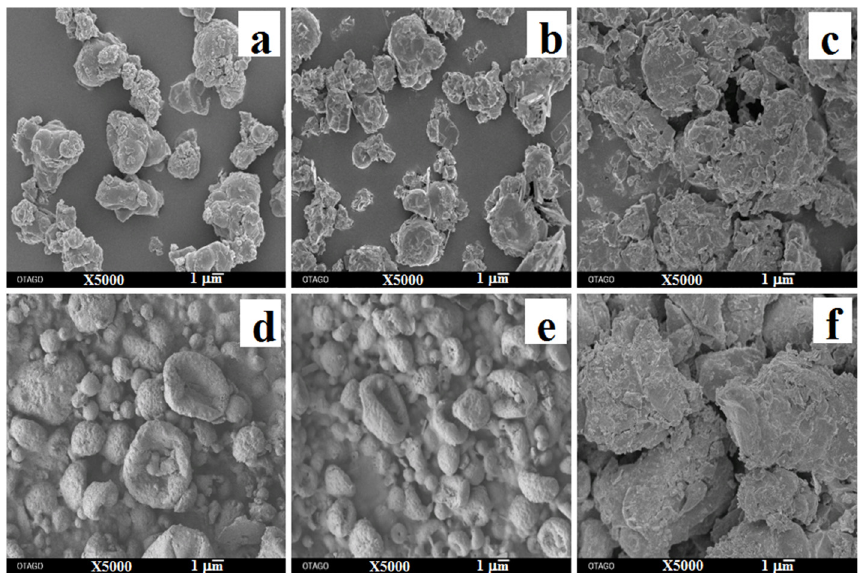
Figure 6. X ‐ ray diffractograms of the spray ‐ dried roflumilast ‐ only ( a ) and cospray ‐ dried ( b ) pow ‐ ders after one month storage at different storage conditions (for ease of comparison, the initial data from Figure 2 are shown here.).